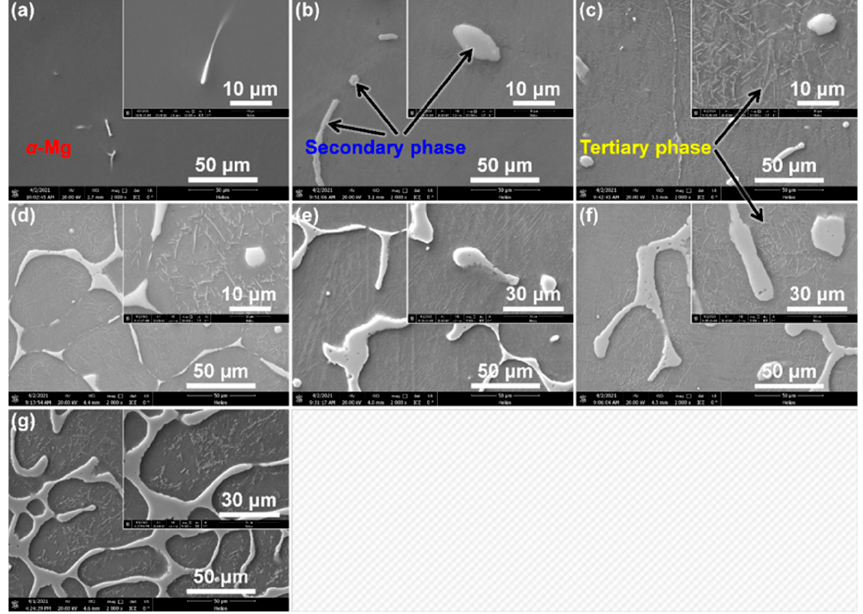
Figure 4. Low- and high-magnification SEM images of precipitate development in Mg–Nd system alloys: ( a ) Mg-1Nd; ( b ) Mg-2Nd; ( c ) Mg-3Nd; ( d ) Mg-4Nd; ( e ) Mg-5Nd; ( f ) Mg-6Nd; ( g ) Mg-7Nd.